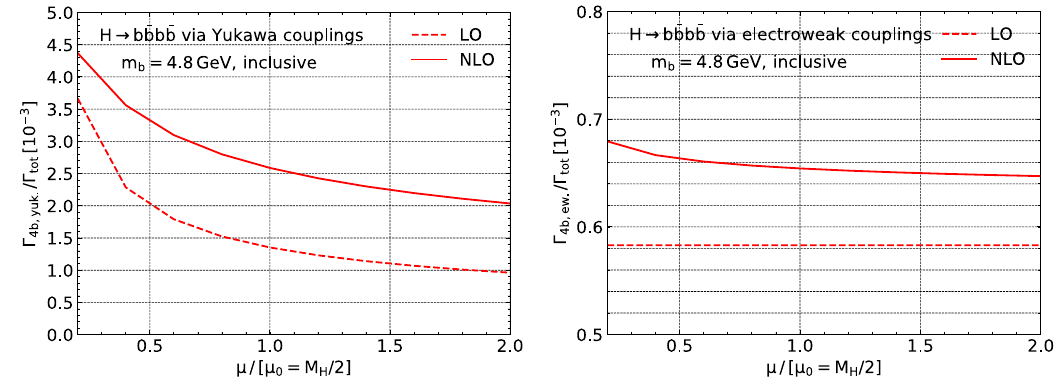
Figure 3 . Decay branching ratio of the Higgs boson to four bottom quarks as a function of the renormalization scale via either Yukawa couplings (left plot) or the electroweak couplings (right plot), at both LO and